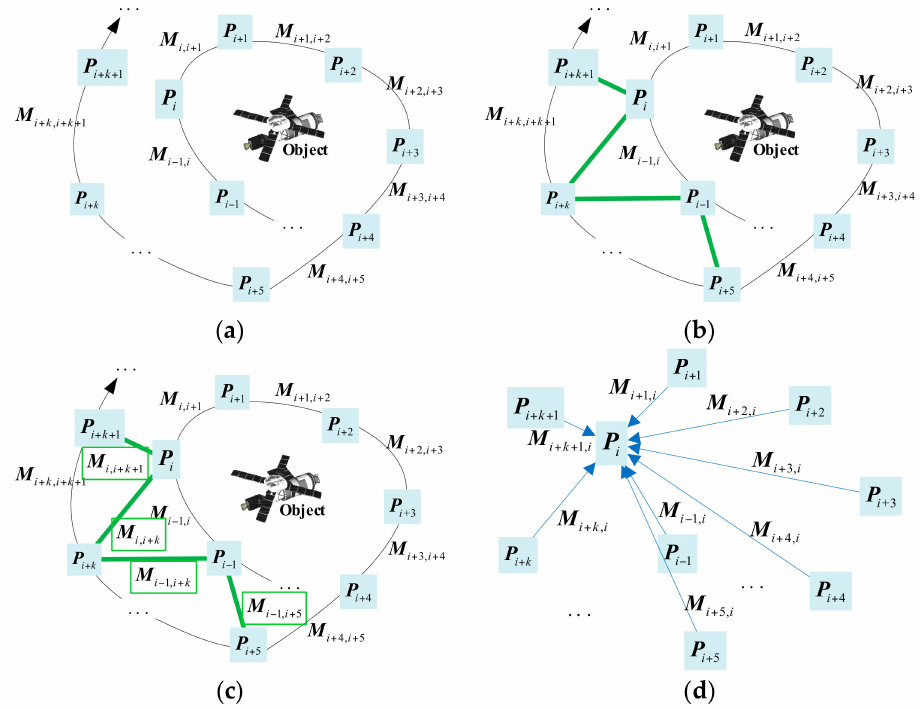
Figure 1. Global registration for single-object multi-view laser point cloud: ( a ) Pre-processing, pairwise registration between the consecutive point clouds; ( b ) loop-closure detection, searching the point clouds which may have several sets of transformation parameters; ( c ) post-preprocessing, pairwise registration between the new pairwise point clouds; ( d ) relation calculation, getting the transformation relationship between all point clouds and transforming them to the same coordinate